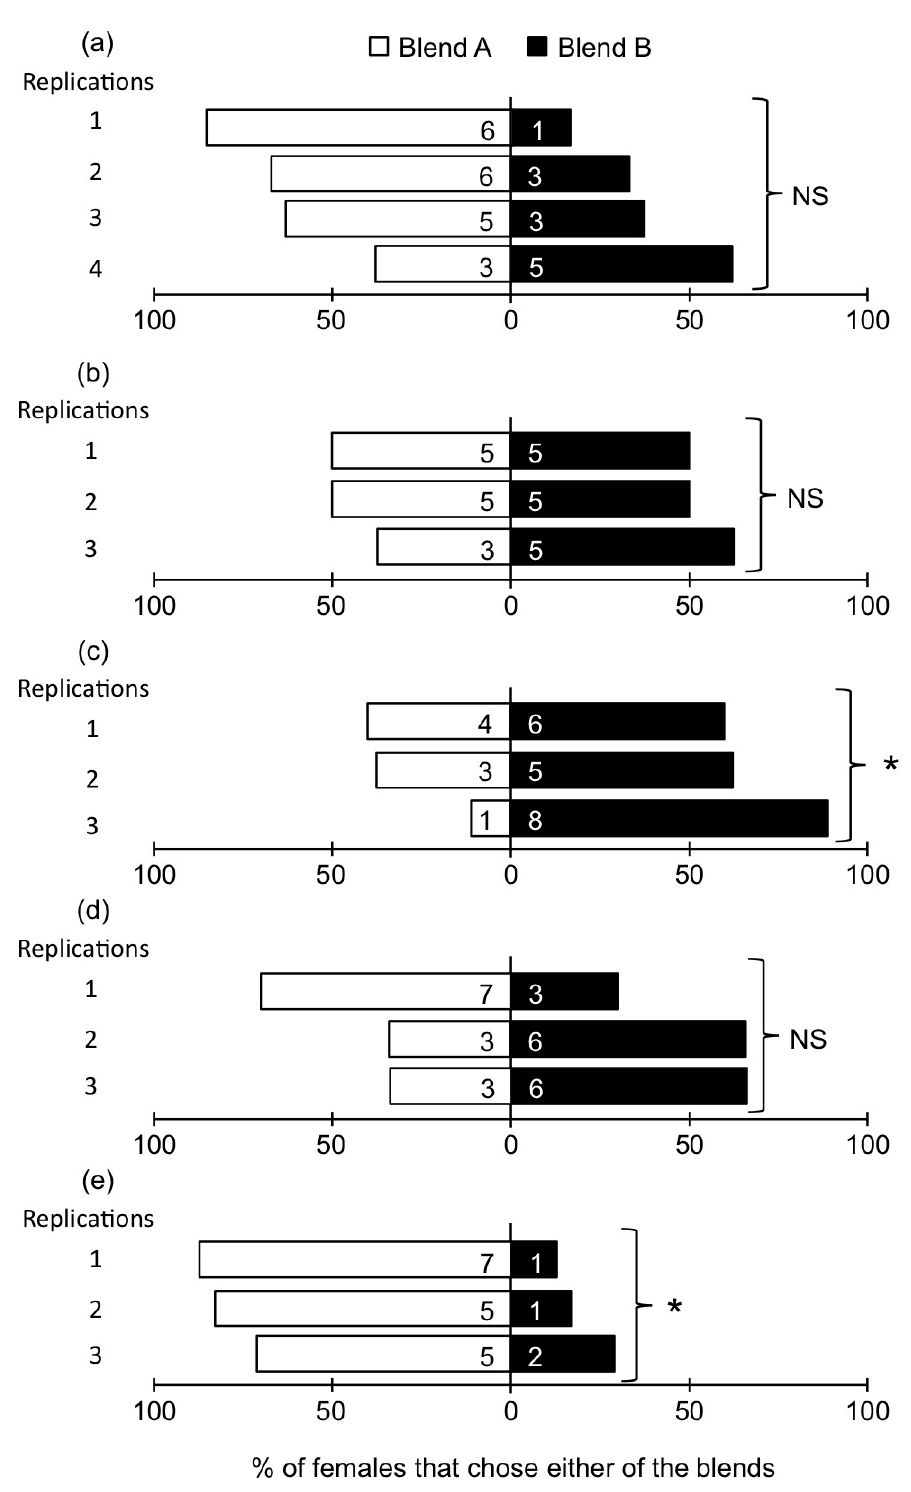
Figure 1. Responses of Cotesia vestalis to Blend A vs. Blend B. Each bar showed % of females that chose either of the blends (x axis). Numbers within bars indicate the numbers of females that landed on each plant. ( a ) Response of naïve C. vestalis . ( b ) Response of C. vestalis with oviposition experience. ( c ) Response of C. vestalis with oviposition experience in the presence of Blend B. ( d ) Response of C. vestalis with starvation experience. ( e ) Response of C. vestalis with starvation experience in the presence of Blend B. *: 0.05 > P > 0.01 , ns: not significantly different by